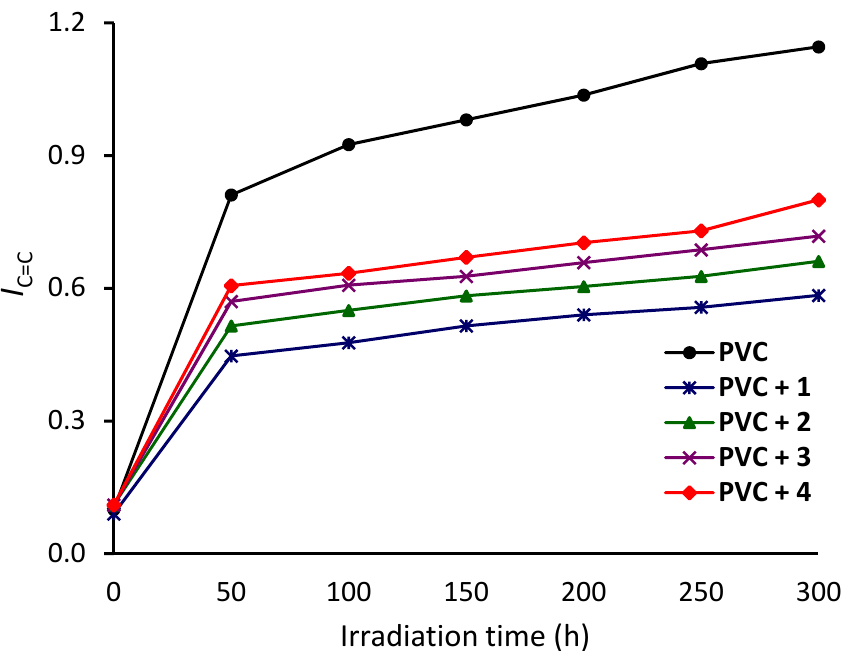
Figure 3. The I C=O of the PVC films versus time.